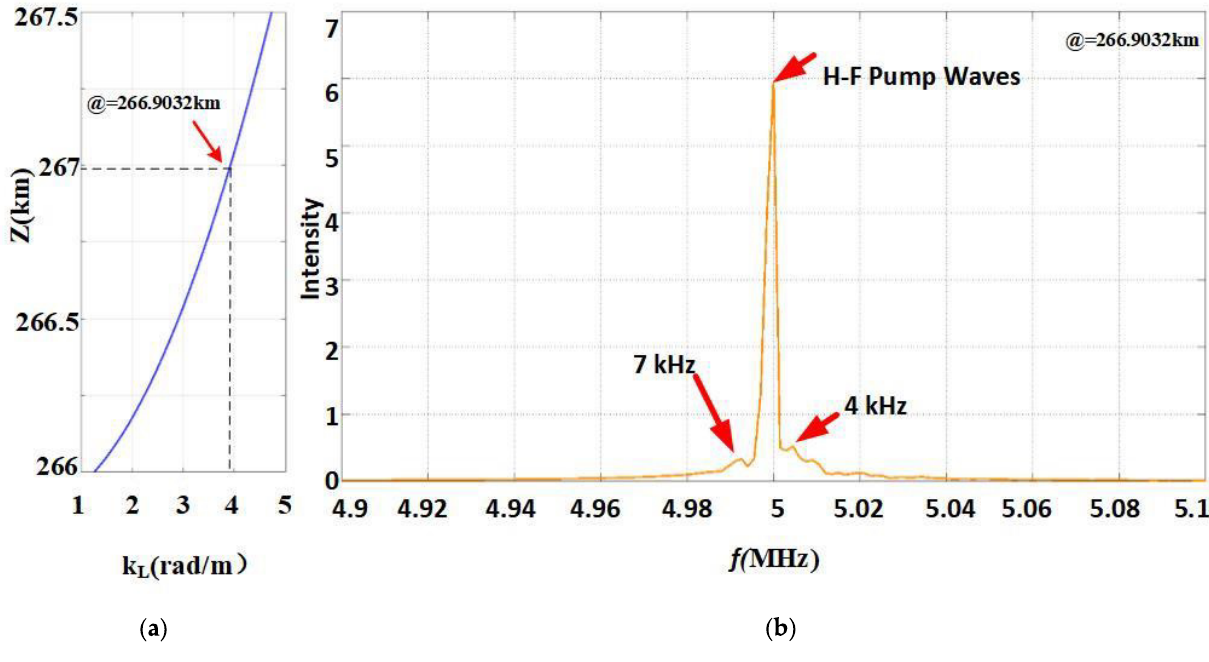
Figure 8. ( a ) The height distribution of the Langmuir wave number. ( b ) Spectrogram analysis for E z at an altitude of 266.9032